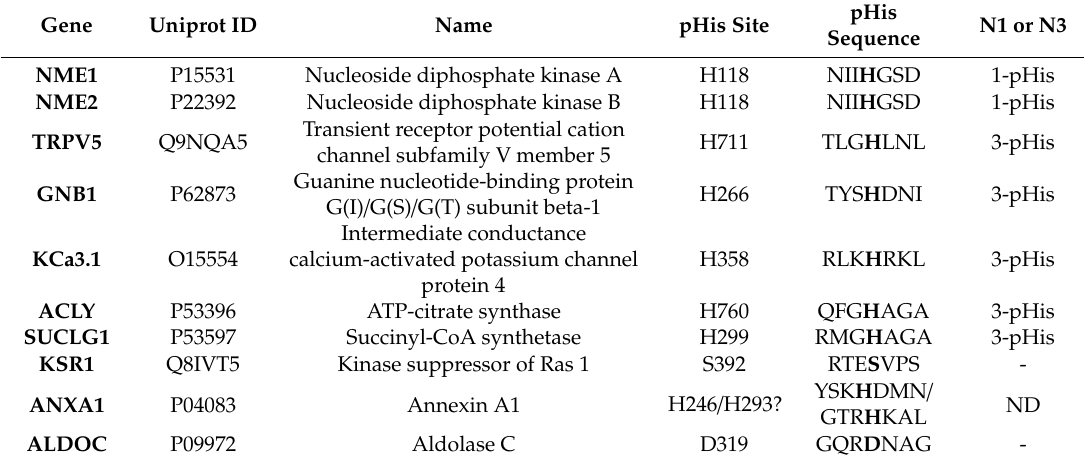
Table 3. Known NME protein